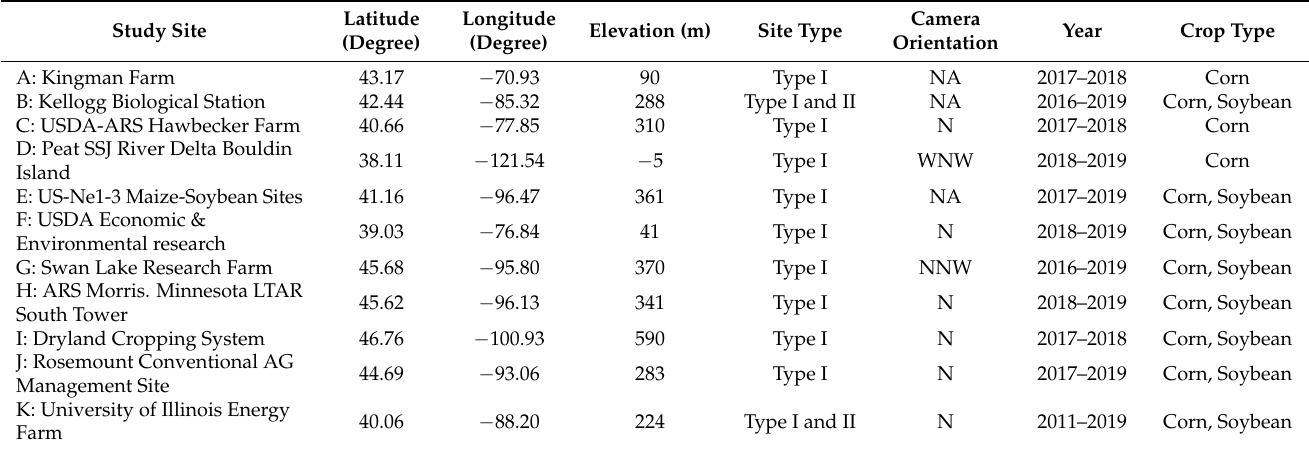
Table 1. Overview of the PhenoCam study sites and site